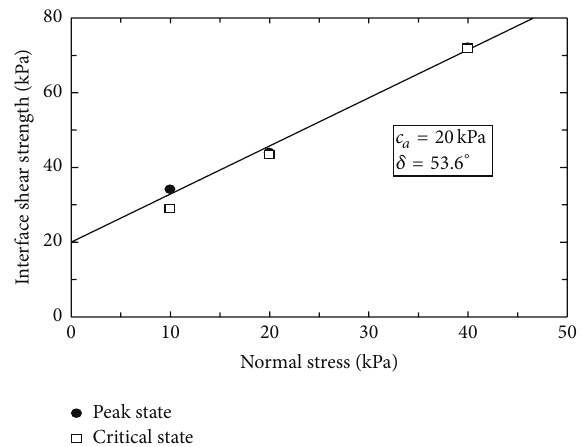
Figure 7: Interface stressfailureenvelope for geogrid reinforced FG.